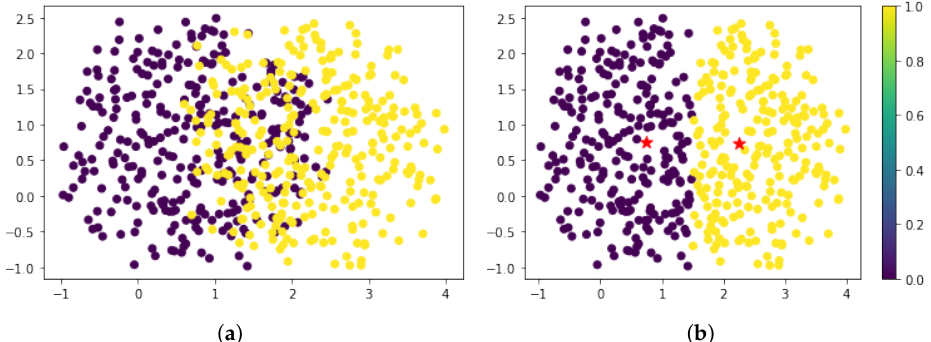
Figure 6. ( a ) Sample overlapped binary class dataset. ( b ) Dataset after removing overlapping region when β t = 0.